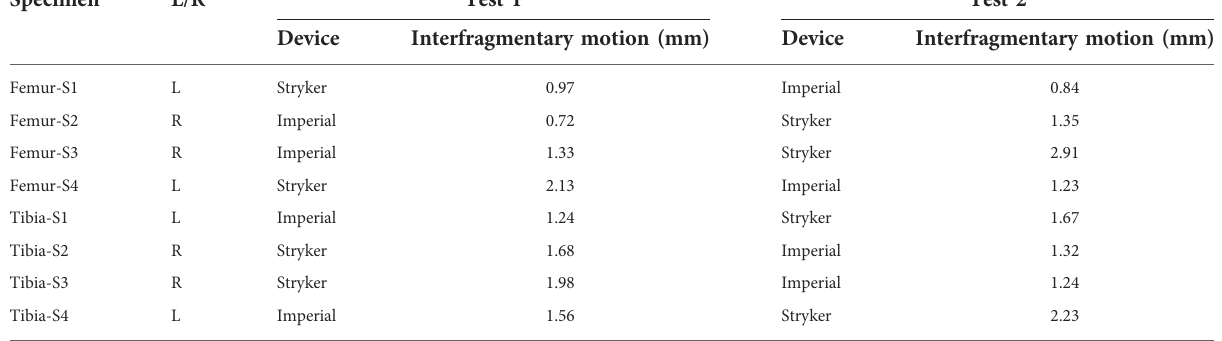
TABLE 3 Measured mean interfragmentary motion in cyclical loading. Specimen